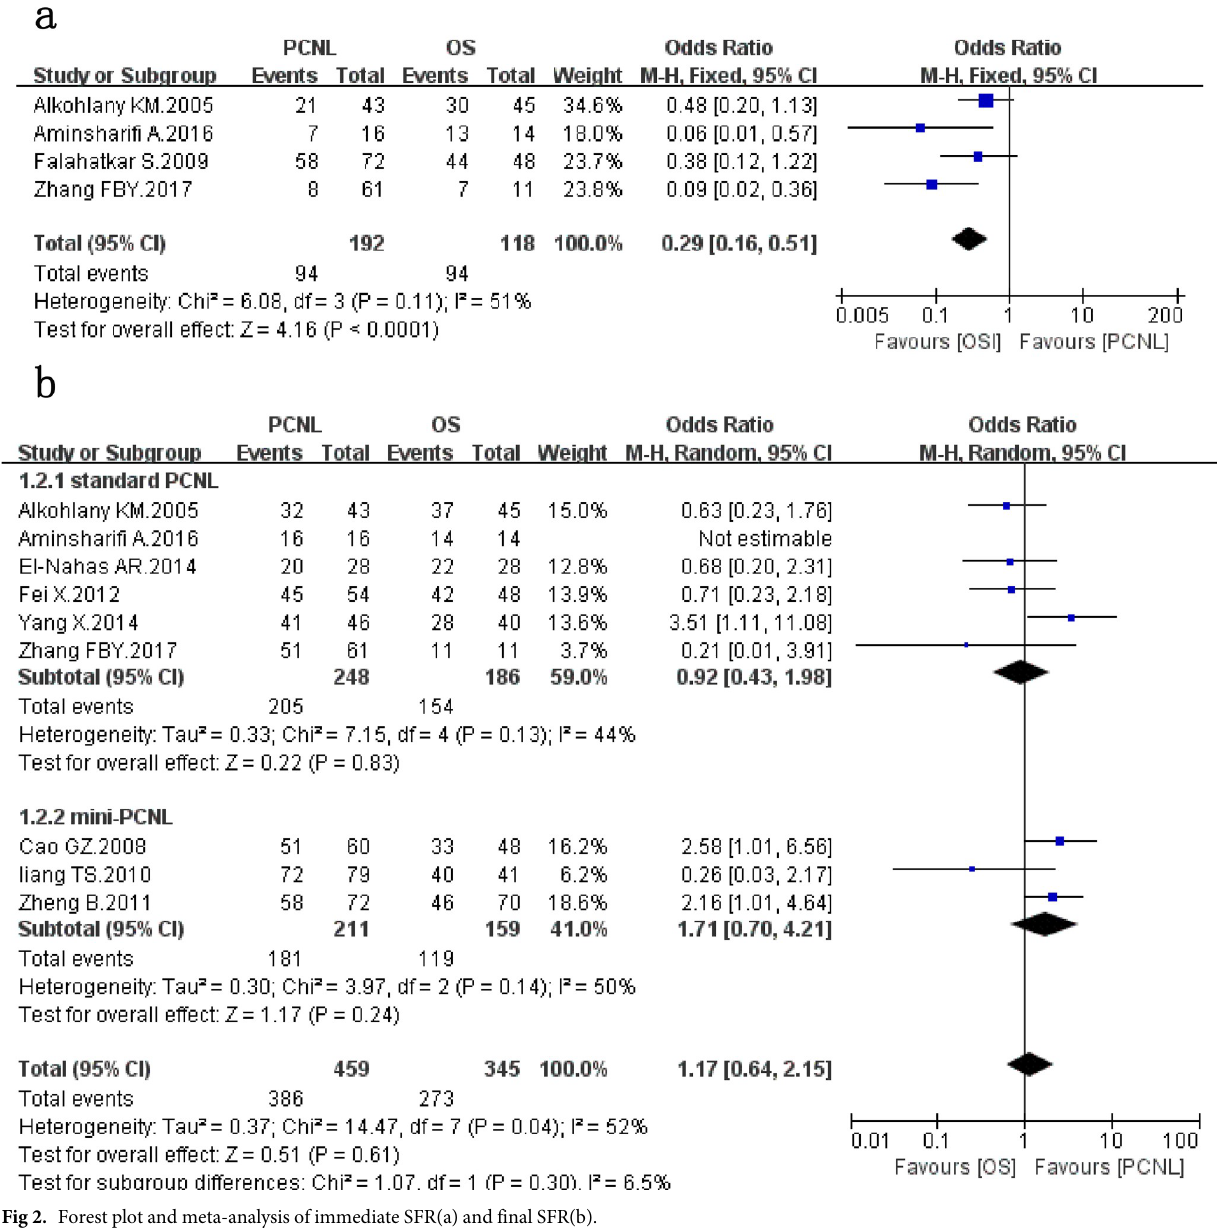
PLOS ONE | https://doi.org/10.1371/journal.pone.0206810 January 31,